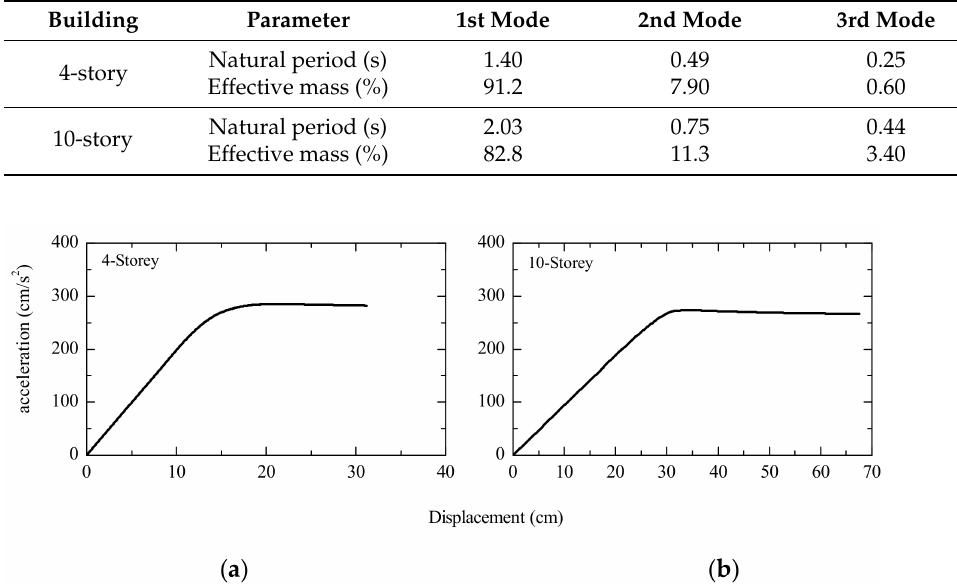
Figure 9. Capacity curve of the ESDOF of target buildings: ( a ) 4-story building, ( b ) 10-story building.